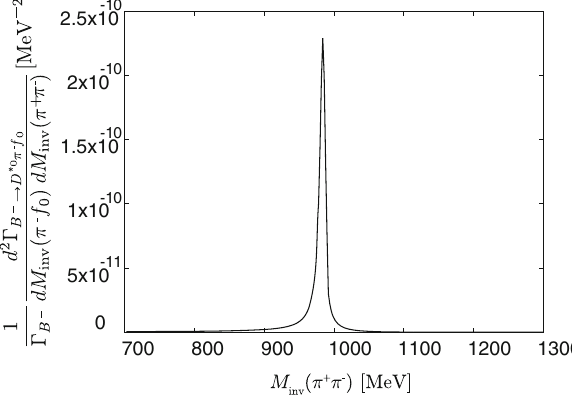
Fig. 6 Thederivativeofthemassdistributionof B − → D ∗ 0 π − π + π